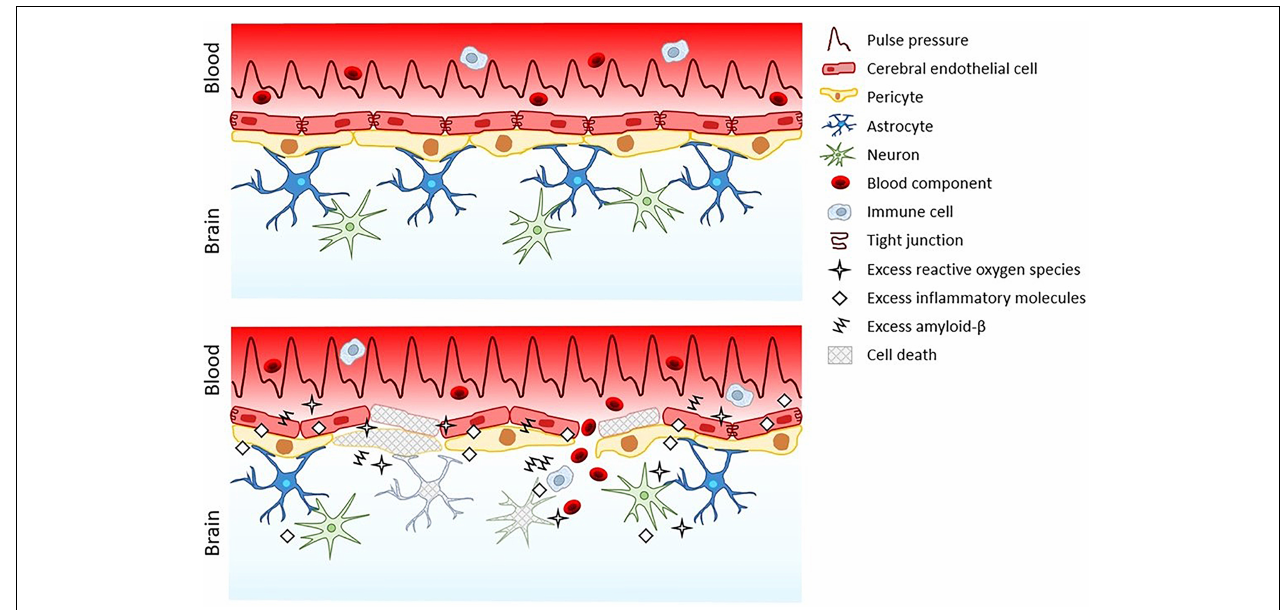
FIGURE 1 | The blood-brain barrier and neuropil under normal pulse pressure (top) versus elevated pulse pressure